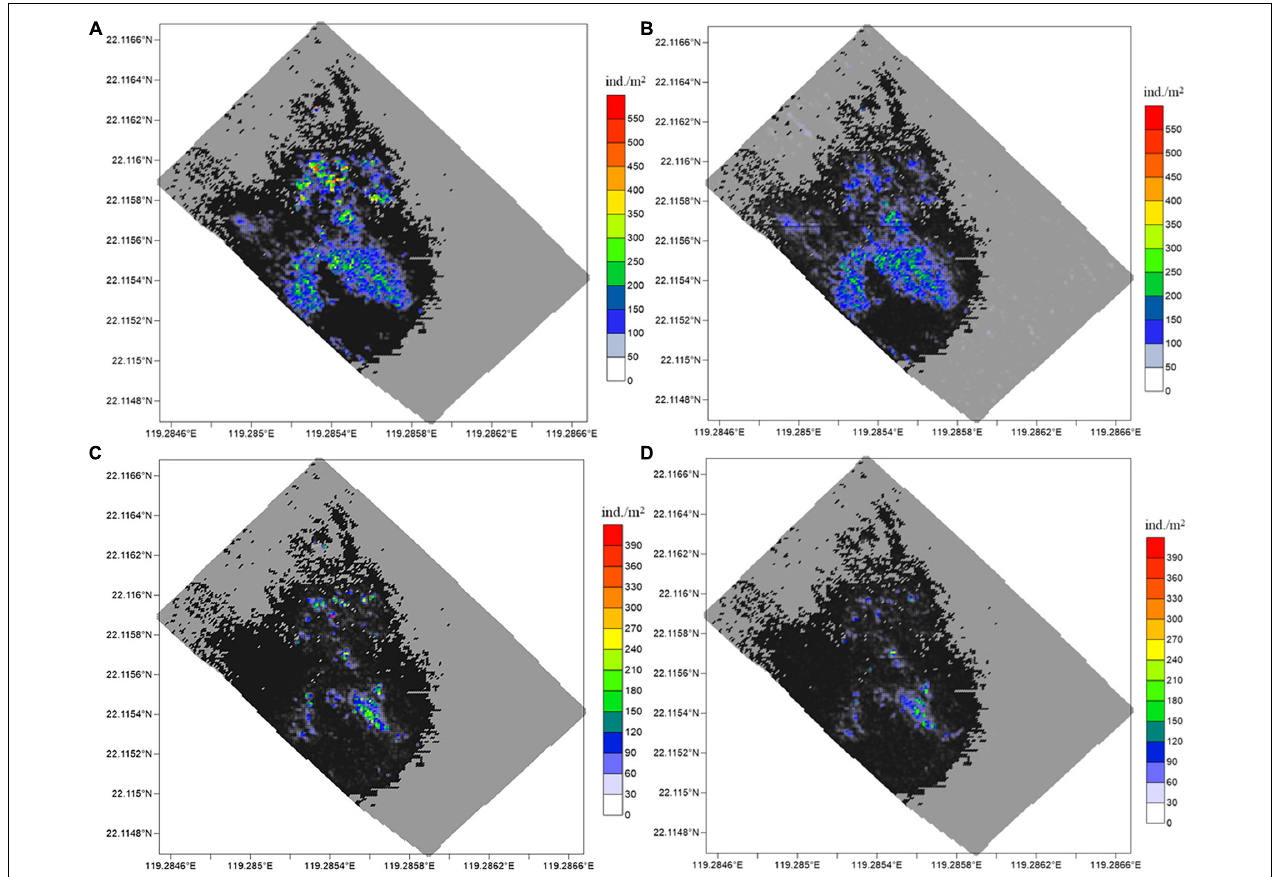
FIGURE 8 | Spatial distribution of G. platifrons and Munidopsidae. The results for G. platifrons with (A) manual counting and (B) model identification, and for Munidopsidae with (C) manual counting and (D) model identification. The large black and gray colored region are hard and soft substrate, respectively.